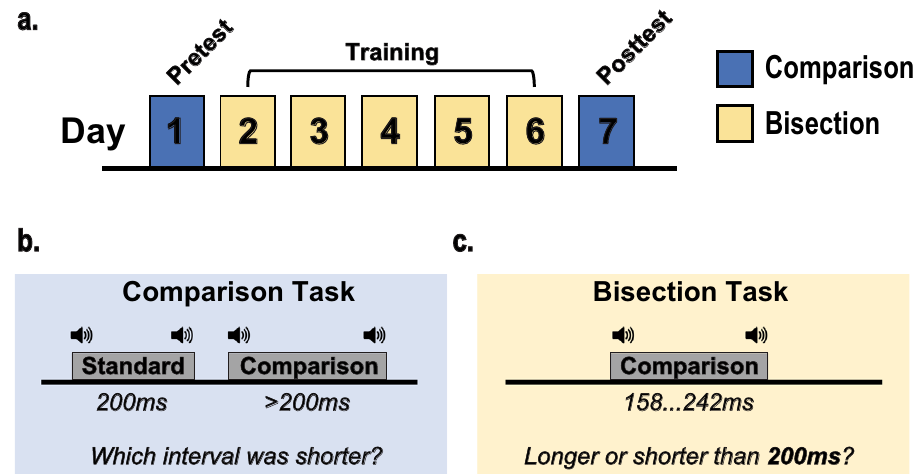
Figure 4. ( a ) Experimental and task procedure. ( b ) Design for the untrained comparison task. Participants indicated which of two auditory tones was longer in duration (i.e., the comparison interval). Presentation